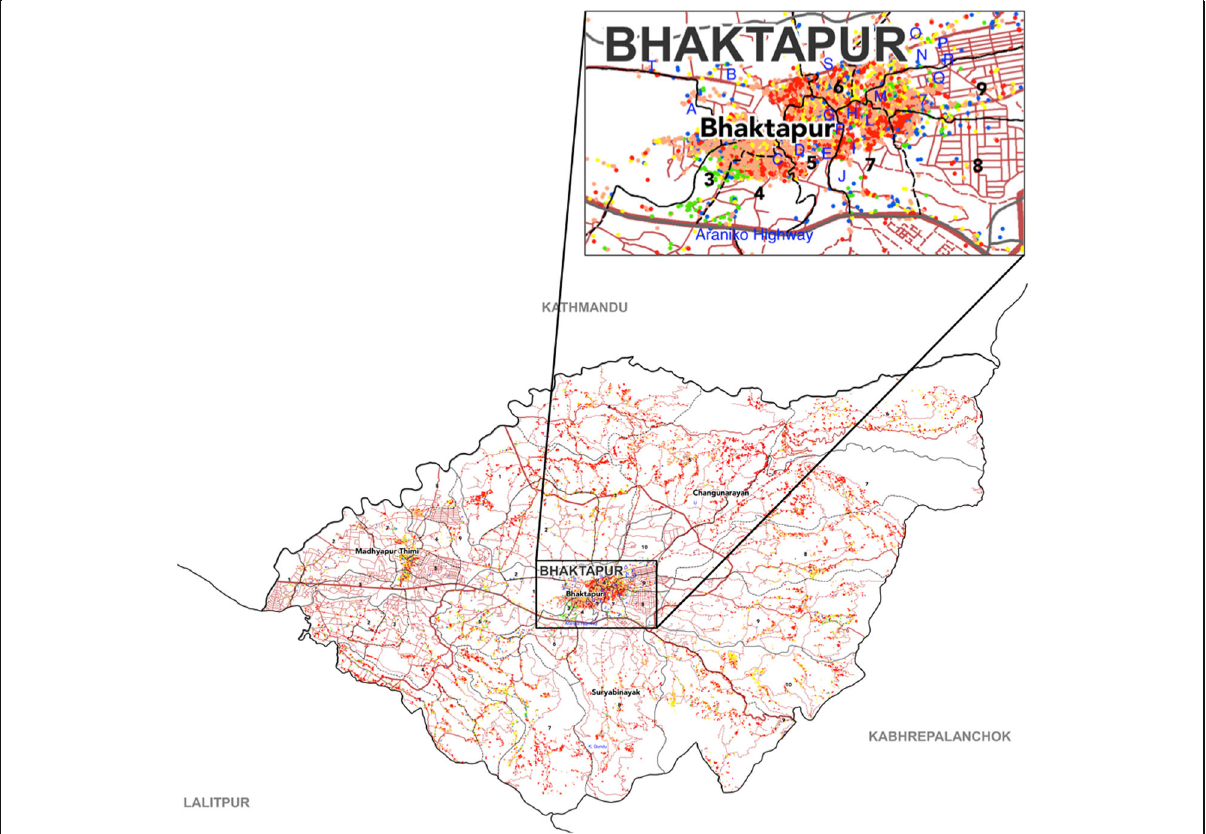
Fig. 1 Earthquake damage map of Bhaktapur district after the 2015 Nepal earthquake. Earthquake damage in Bhaktapur district after the earthquake. The map is adapted and approved to publish from Housing Recovery and Reconstruction Platform (HRRP-Nepal) (http://hrrpnepal. org/maps/ accessed on 2018 December 20). Grades of damage are in an incremental order from 1 to 5; these are shown in green, pink, yellow, orange, and red dots, respectively. English alphabets are designed in the places where temporary shelters were situated after the 2015 Nepal